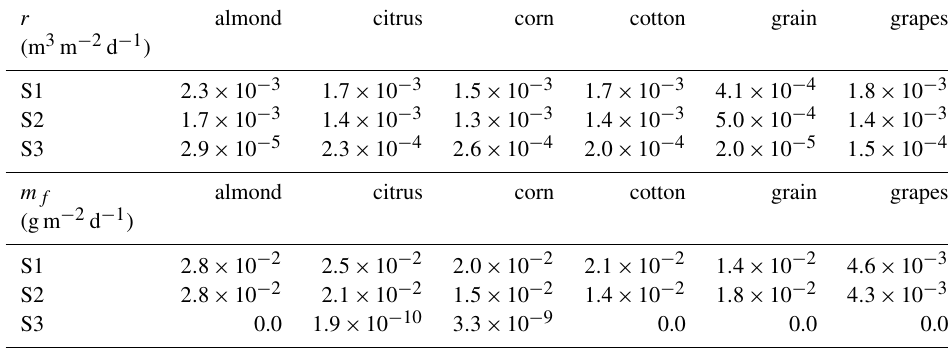
Table 5. Recharge rate and nitrate mass flux applied for each crop–soil-type combination. r almond citrus corn cotton grain grapes